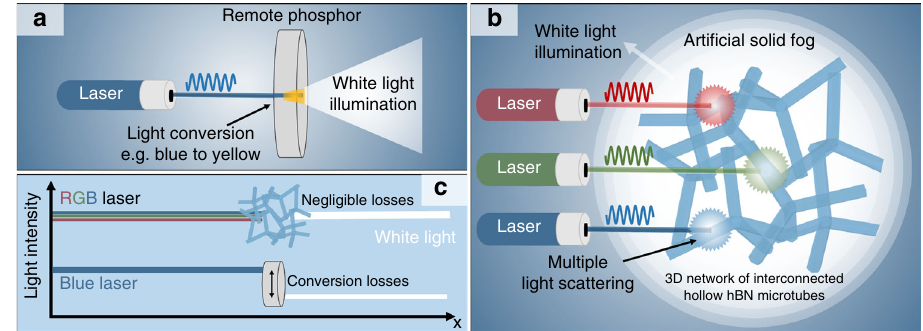
Fig. 1 Schematics of laser-based lighting concepts. a White-light generation by employing a remote phosphor that converts a part of the blue laser light into yellow light resulting in white light. b White-light generation based on an arti fi cial solid fog in combination with an R + G + B laser system. A macroscopically expanded porous (>99.99%) network of interconnected and hollow hBN microtubes with nanoscopic wall thickness is used to convert directed laser light into an isotropic high-brightness white light source, exploiting multiple light scattering. c Schematic comparison of ef fi ciencies of both systems. In the case of remote phosphor, light conversion results in a strong ef fi ciency reduction, whereas the negligible absorption and conversionless light-scattering properties of the hBN foam allow for almost zero losses in light